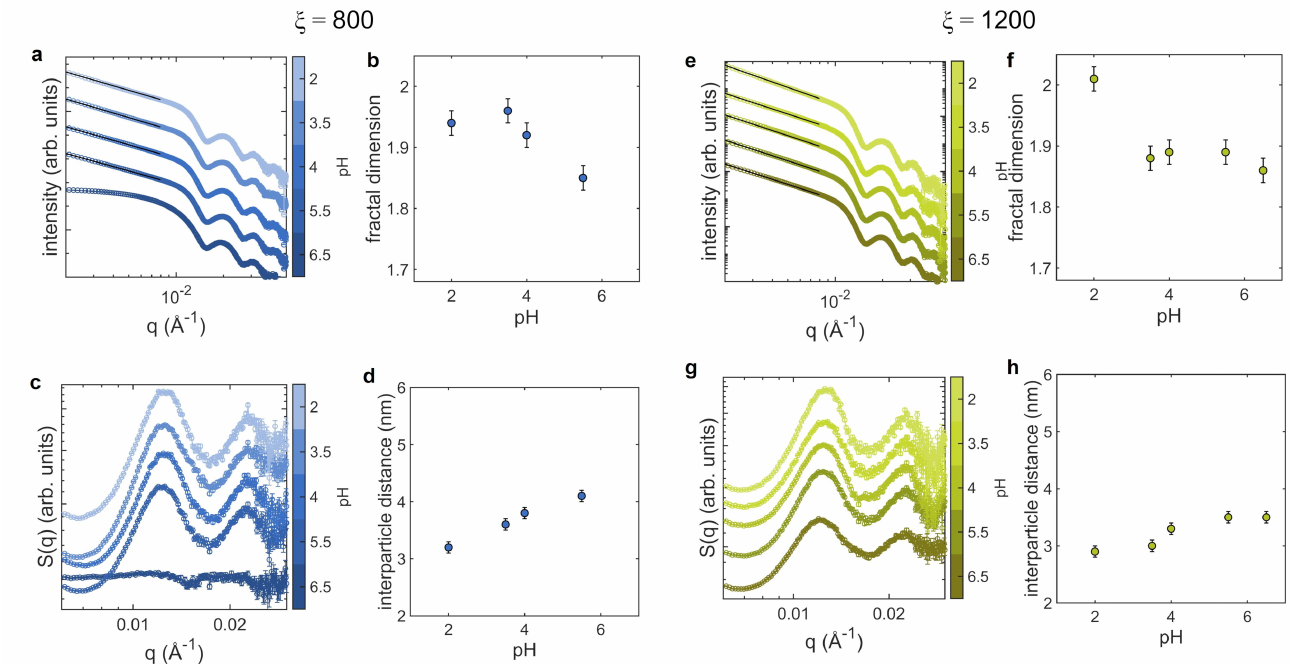
Figure 3. SAXS analysis of the AuNPs clusters morphology as a function of pH in acidic conditions (pH between 2 and 6.5), performed at 25 °C for two different lysozyme-AuNPs number ratios, ξ = 800 and ξ = 1200. ( a , e ) SAXS curves (circles) and power-law decay fitting curves (black lines); ( b , f ) fractal dimension as a function of pH; ( c , g ) structure factors; ( d , h ) interparticle distance as a function of pH. SAXS curves and structure factors are shifted vertically for